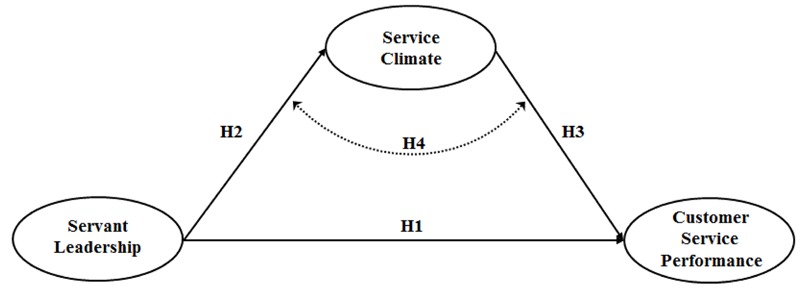
Hypothesized model.